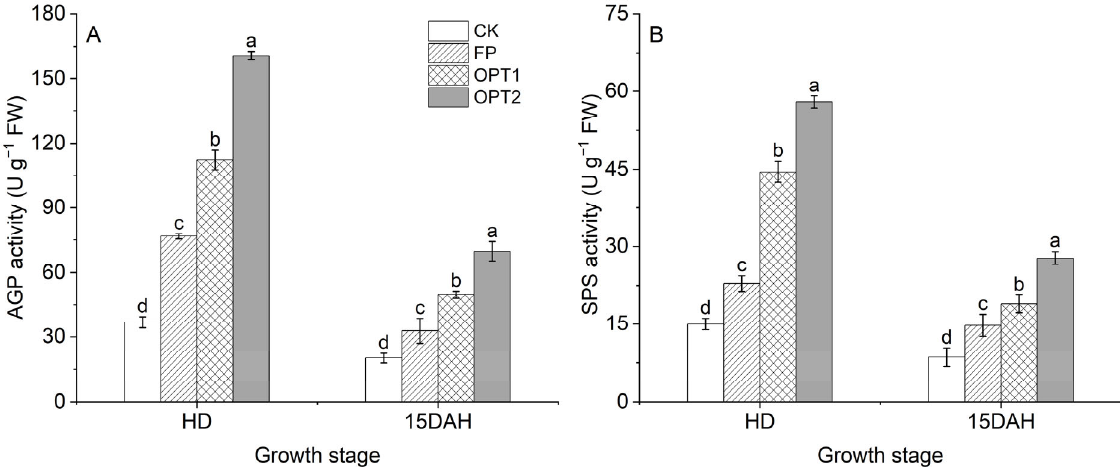
Figure 5. The carbon metabolism-related enzyme activity of AGP ( A ) and SPS ( B ) under four management systems at HD and 15DAH. Means followed by the same letter do not significantly differ (LSD, p < 0.05).